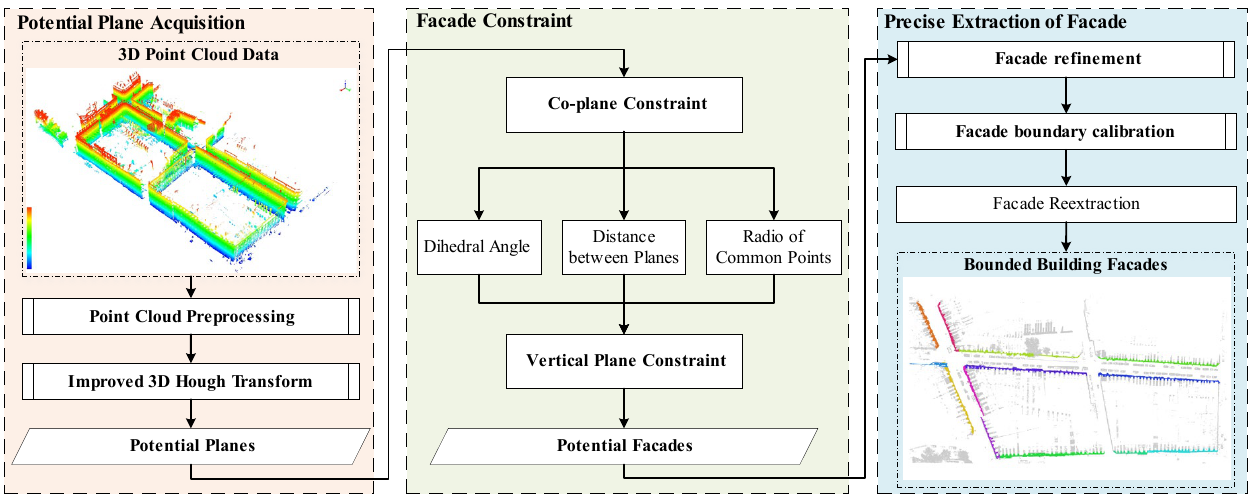
Figure 1. Processes of building facade extraction.